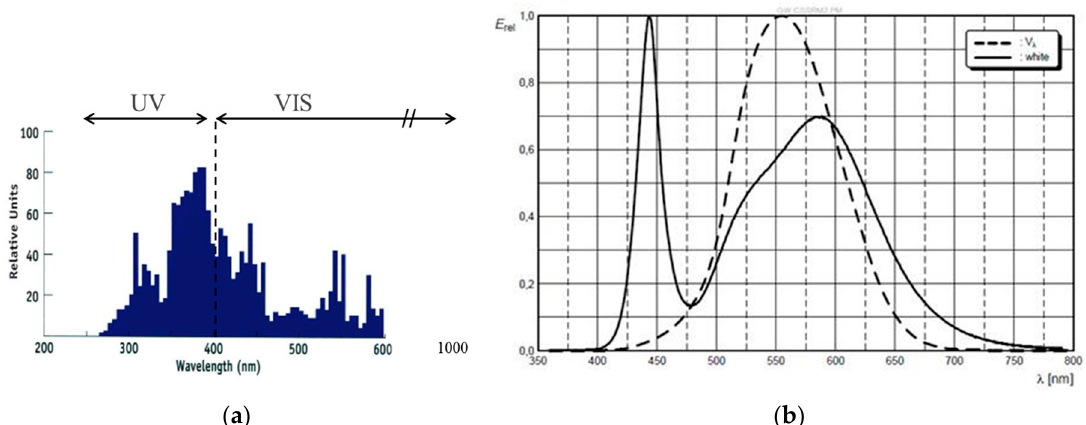
Figure 16. ( a ) UV light-curing flood lamp spectral distribution from a standard metal-halide bulb (DYMAX 2000; source: www.dymax.com). Indicated are also the UV and VIS radiation components as defined by the sensitivity of the detectors (Gigahertz-Optik–X11 Optometer; UV: UV-3719-4; VIS: RW-3705-4); ( b ) White LED Philips ClearFlood BVP650